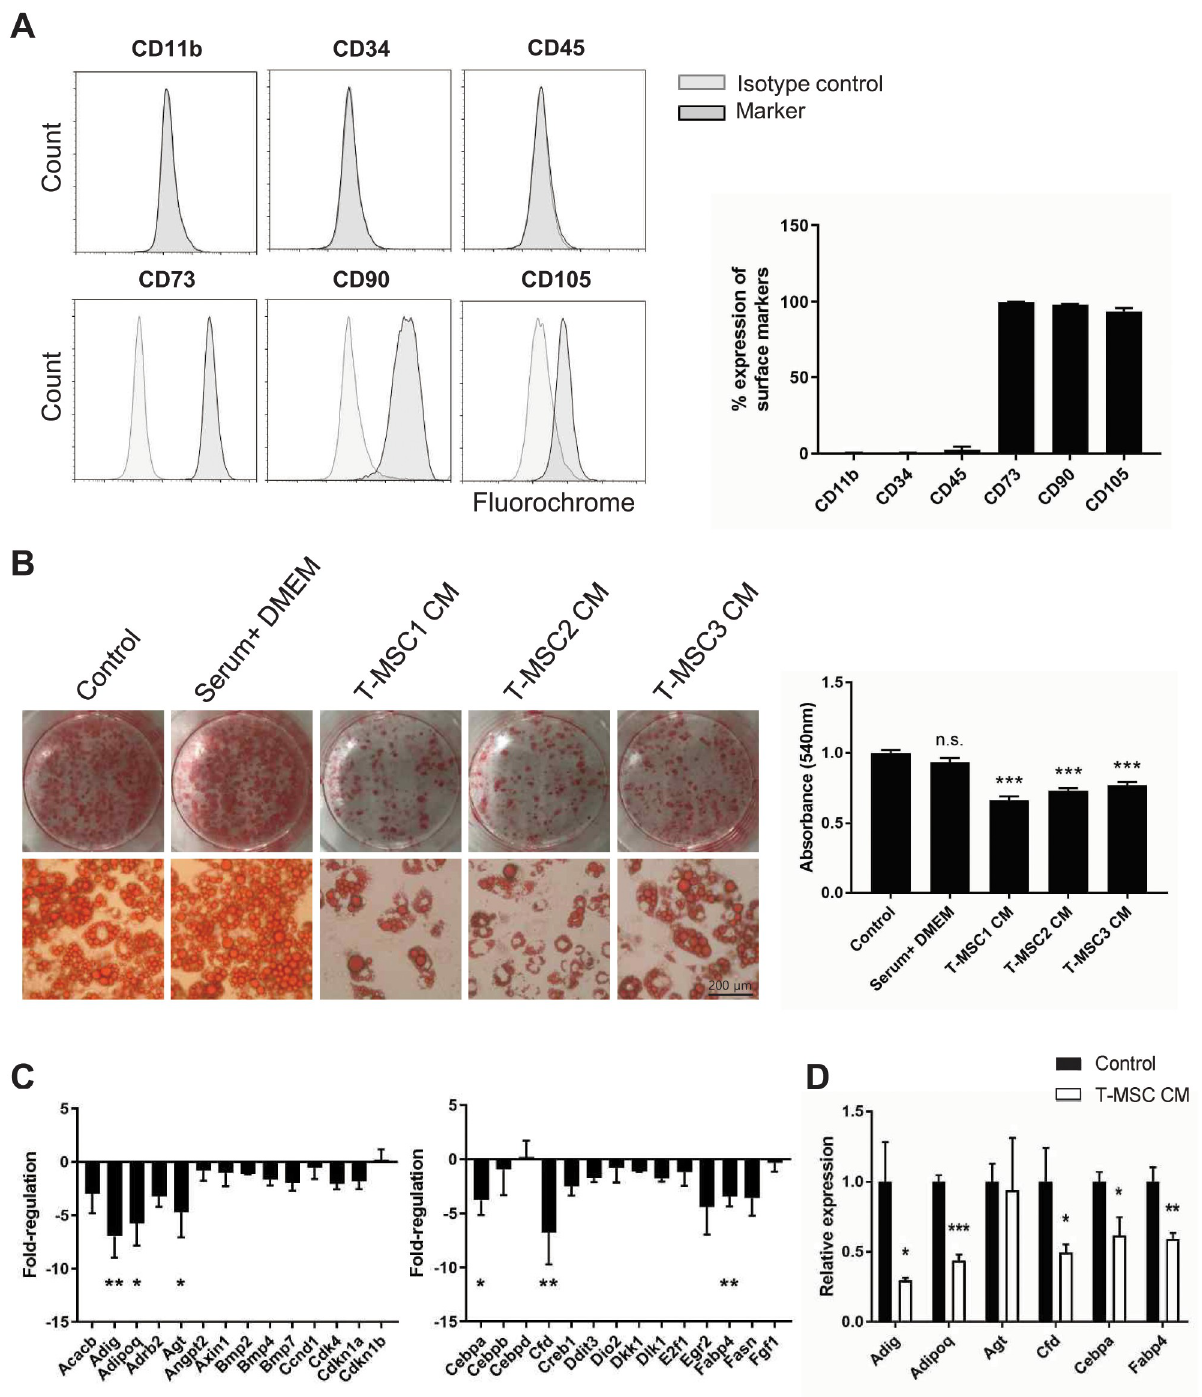
Fig 1. T-MSC CM attenuates adipocyte differentiation from early stages. A) Surface marker expression in T-MSCs from three different donors was examined by flow cytometry. Representative plots are shown and percentage expression of each marker is demonstrated (n = 3). B) 3T3-L1 preadipocytes underwent adipocyte differentiation induction in the presence or absence of T-MSC CM for 10 days. Lipid accumulation was determined using Oil Red O staining. Cells were treated with T-MSC CM from three different donors or serum-containing DMEM. Representative images are shown (200 × original magnification). Quantification of Oil Red O staining measured at absorbance 540 nm. (C) Fold change in expression of genes involved in adipogenesis relative to control were determined in cells induced for differentiation for 3 days using an adipogenesis PCR array. Data were analyzed using one-way ANOVA (n = 3). (D) mRNA expression of differentially expressed genes was confirmed by RT-qPCR. Data are shown as mean ± SEM and were analyzed using Student’s t -tests (n = 3, � P < 0.05, �� P < 0.01, ��� P < 0.001).